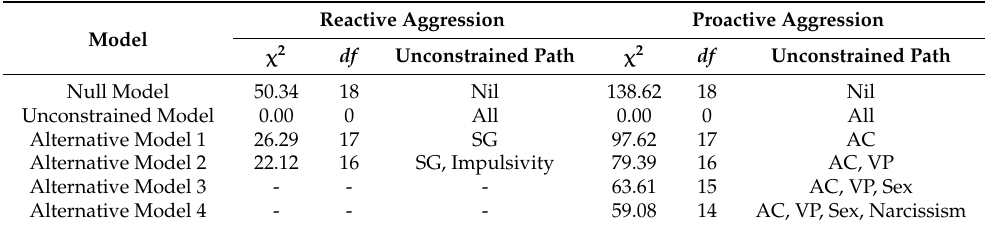
Table 6. Multiple Group Model